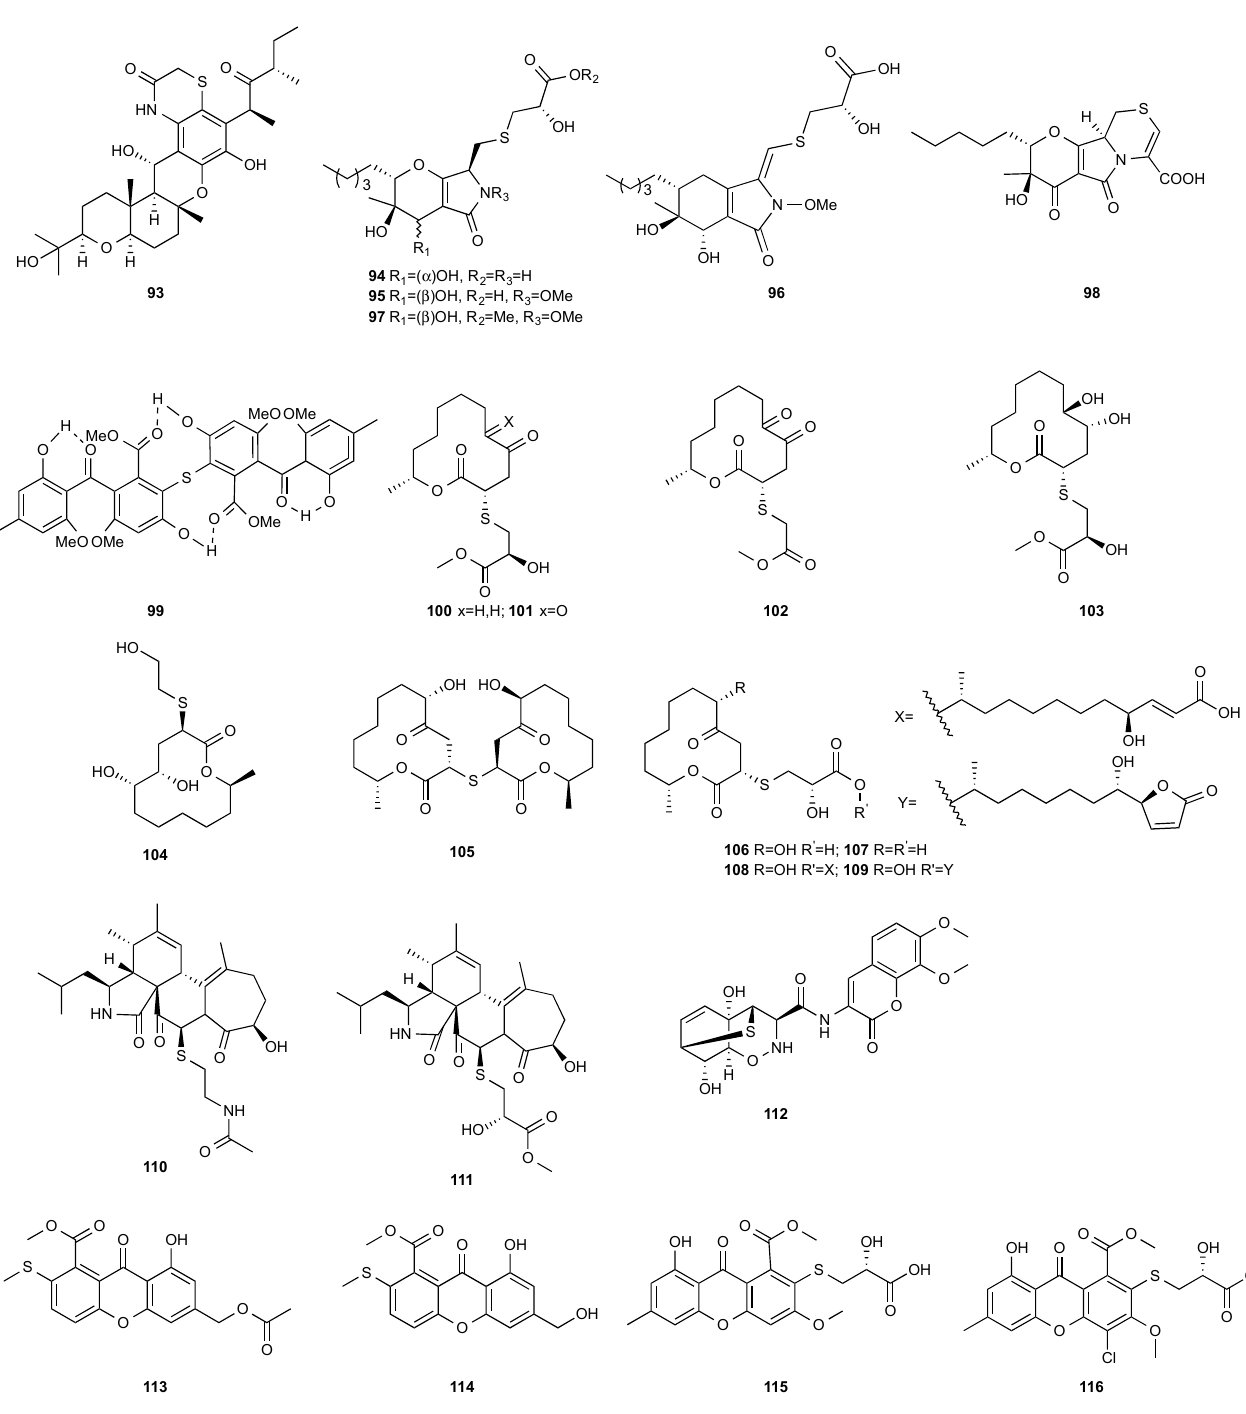
Figure 4. Structures of compounds 93 – 116 .